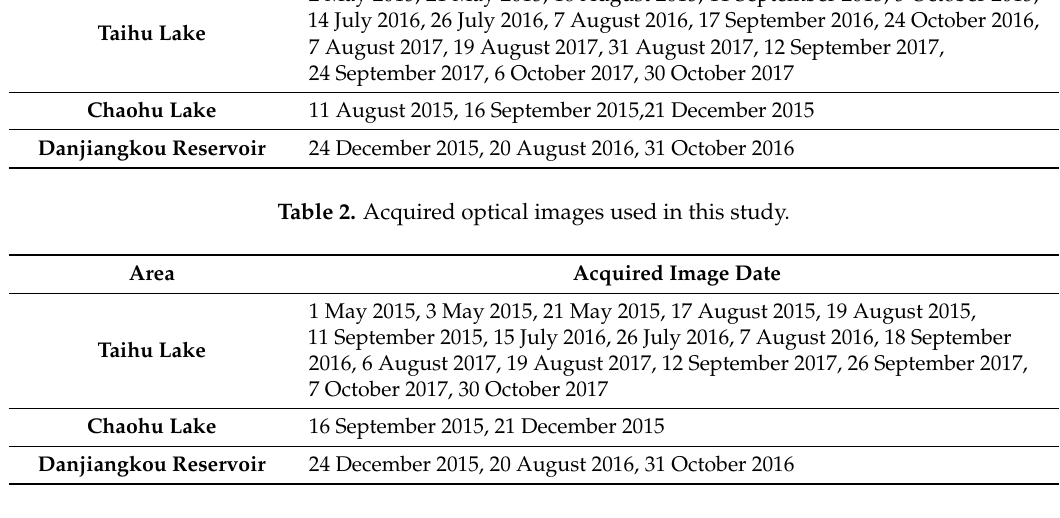
Table 1. Acquired SAR images used in this study.